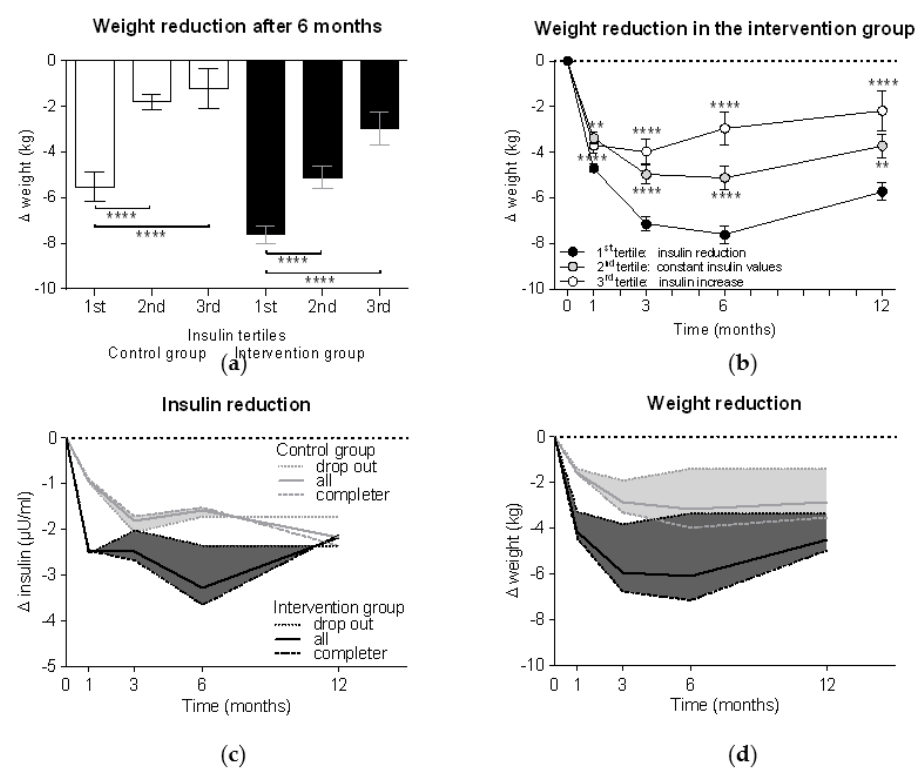
Figure 3. Weight reduction is related to insulin reduction. Participants were divided into three tertile groups according to their changes in insulin levels after six months compared to the baseline (1st tertile = insulin reduction of > 2 µU/mL; 2nd tertile = constant insulin values with changes ≤ 2 µU/mL; 3rd tertile = insulin increase > 2 µU/mL). Weight reduction ( a ) after six months in both groups and ( b ) in the intervention group alone ( n = 301) during the whole study period was com- pared between tertile groups using Kruskal-Wallis test with Dunn’s multiple comparison test (**, p < 0.01; ****, p < 0.0001). Subanalyses of reduction in ( c ) insulin levels and ( d ) weight were performed for dropouts ( n = 44 in the control group and n = 85 in the intervention group) and completers ( n = 101 in the control group and n = 216 in the intervention group). The areas between the curves of the dropouts (dotted lines) and the completers (dashed lines) were filled with colour and the curves of the whole group (solid lines; here described with “all”) were added. 4. Discussion The international multicentre randomised controlled ACOORH trial demonstrated the superiority of a lifestyle intervention accompanied by a dietary change of a high-protein, low-glycaemic meal replacement compared to a control lifestyle interven- tion alone. Consequently, this superiority led to a greater reduction in fasting insulin levels. Furthermore, the insulin reduction correlated with the achieved weight reduction and was accompanied by improvements in inflammation markers. Participants who prematurely ended meal replacement still achieved insulin and weight improvements comparable to the control group. After the end of the intervention, both insulin levels and weight increased again but remained significantly below baseline levels. In this subanalysis of the ACOORH trial, we primarily focused on fasting insulin as insulin not only mediates glucose uptake from the blood into the cells but also has further physiological regulatory functions. For example, insulin inhibits lipolysis at a much lower concentration than it is needed for glucose uptake [1]. By using a microdialysis technique in combination with a three-step hyperinsulinaemic glucose clamp, Jacob et al. [2] demonstrated in nineteen lean, healthy subjects that low physiological concentrations